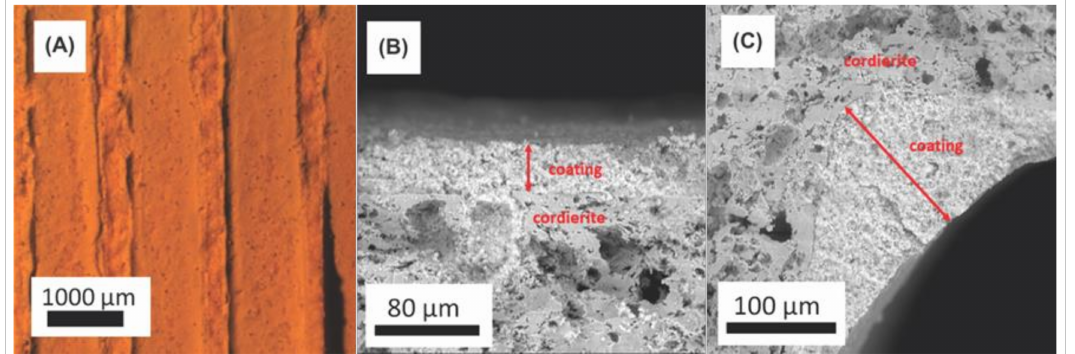
Figure 2. Images of Cs 2 CoM structure: ( A ) optical microscopic image of a cross-section along the channels; ( B ) SEM image of a cross-section; ( C ) SEM image of